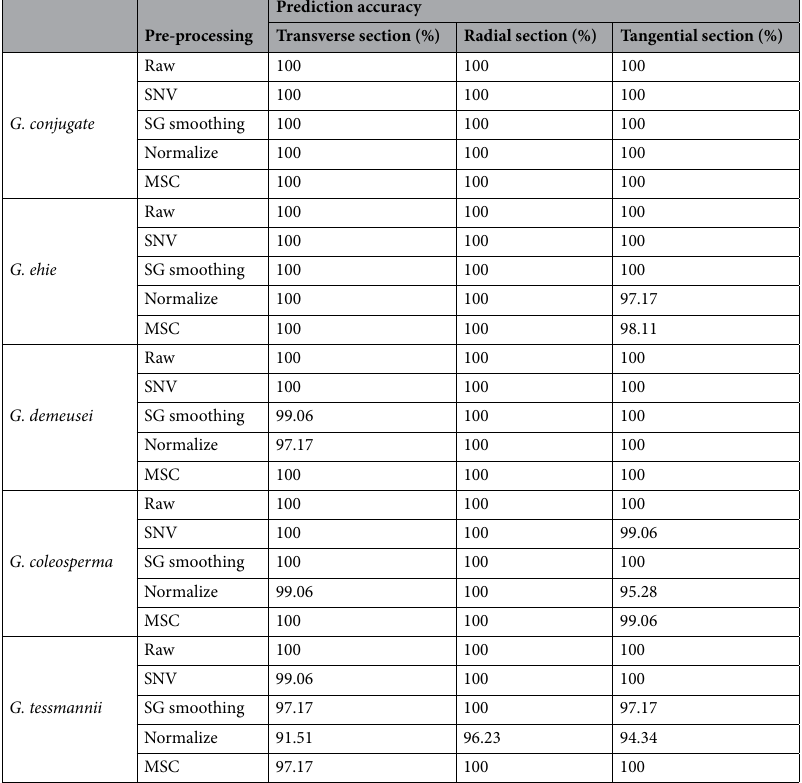
Table 5. Summary of the prediction results of SVM model (based on SPA treatment).